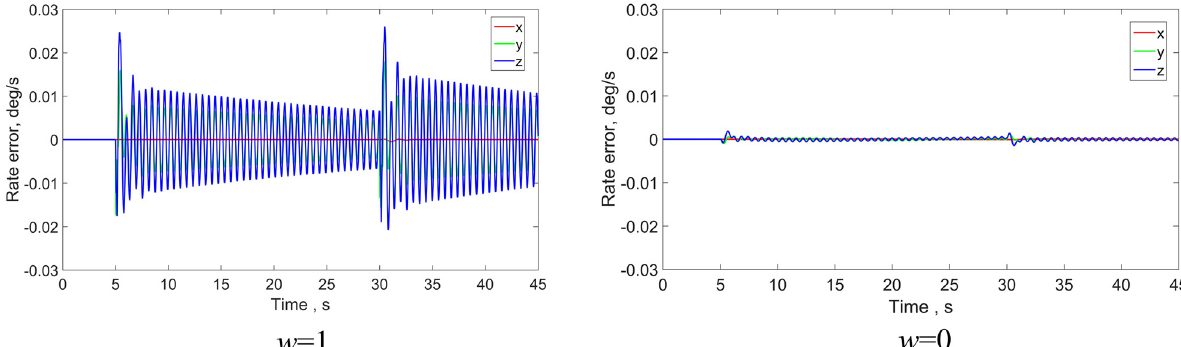
Figure 27: Rate attitude errors for case